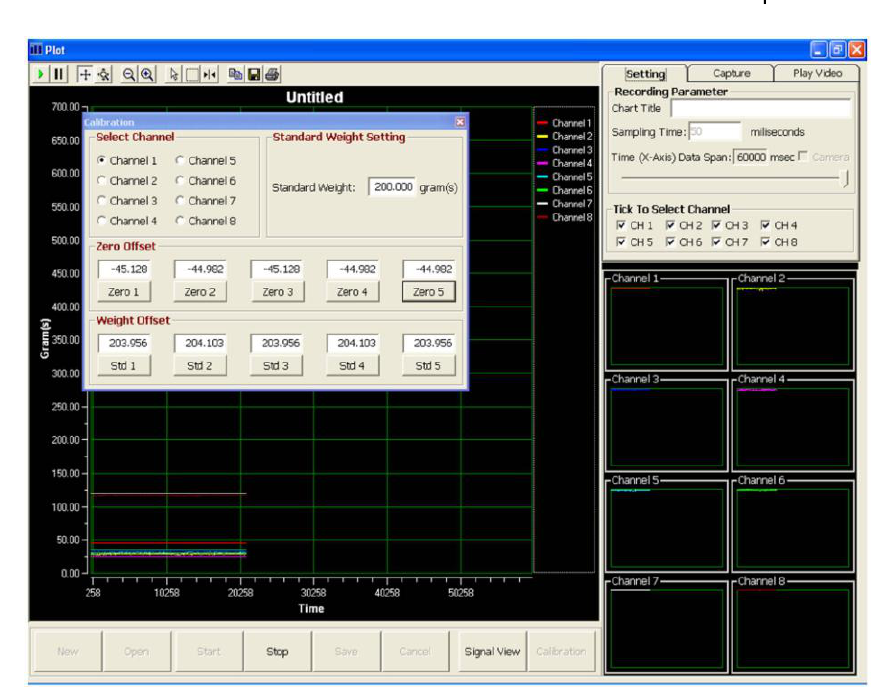
Figure 4. New calibration with ‘OFFSET’ and Y = mX + C linear equation